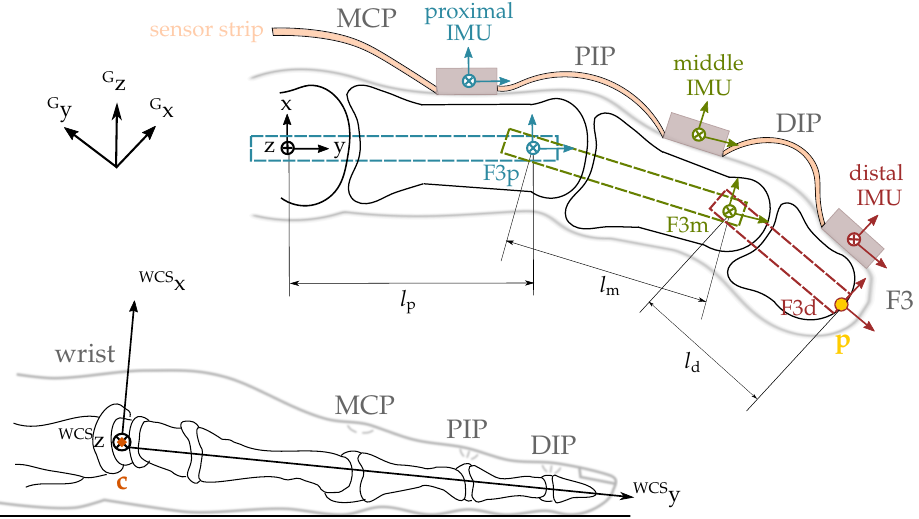
Figure 5. Top: model terms for the exemplary finger F3 of a left hand and location of coordinate frames: IMU frames as well as bone frames (both no index) located in the centers of rotation and the inertial global coordinate frame (index G). The IMU and bone frames are assumed to differ only by a constant translational offset. l p , l m , and l d denote the functional lengths of the proximal, middle, and distal phalanges. The point p marks the fingertip position of interest. Bottom: wrist coordinate system (WCS) located in the center c of rotation of the wrist for the left